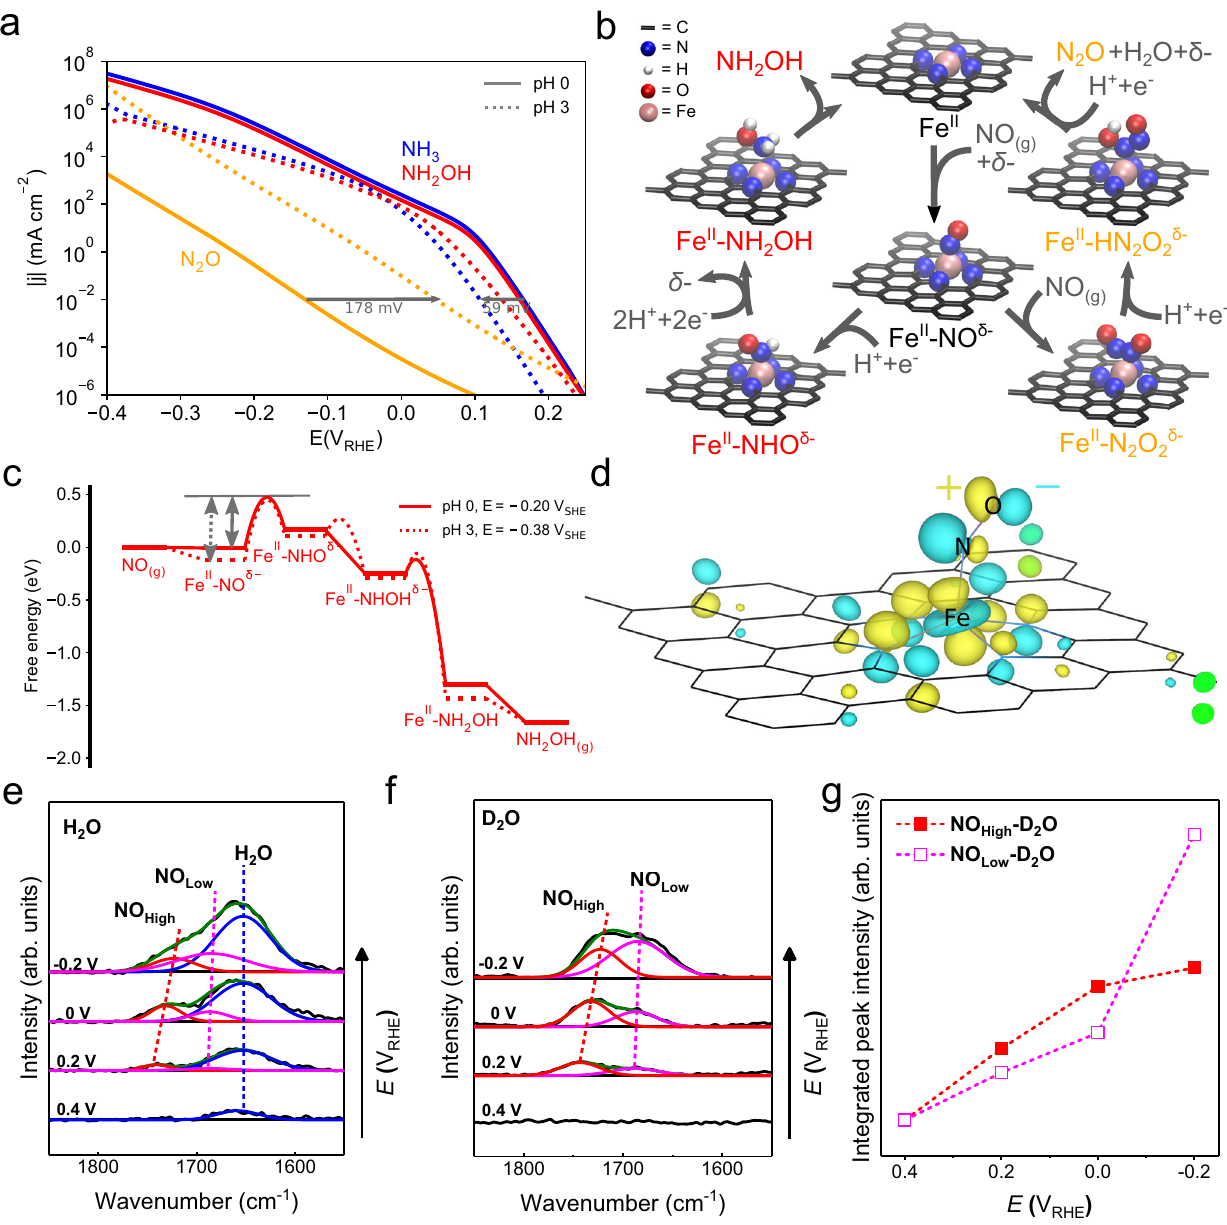
Fig. 3 First-principles based electrochemical multiscale simulation studies and in situ ATR-SEIRAS analyses on the mechanism of NORR at graphene- embedded Fe – N 4 moiety. a Polarisation curves from micro-kinetic modelling relying on HSE06-based adsorption energies showing the partial current densities of three different NORR products for pH 0 and pH 3 on an RHE scale. Horizontal arrows depict the overpotential shift with pH. b Reaction mechanism with the key rate-limiting intermediates as obtained from analysis of the micro-kinetic modelling results. c Free energy diagram for NORR to NH 2 OH (HSE06 level) at − 0.2 V RHE for two different pH values. The grey arrows indicate that the more negative corresponding potential on an SHE scale at pH 3 leads to an additional stabilisation of Fe II – NO δ − relative to the transition state towards the Fe II – NHO δ − state on an RHE scale. The x -axis corresponds to the overall reaction coordinate being decomposed into the elementary steps (containing both PCET and chemical steps). The free energy diagram has been evaluated without accounting for pressures and coverages. d Spin-up HOMO of the Fe II – NO δ − state at the PZC (at the Γ -point and an isovalue of ±1.5 × 10 − 3 ) (RPBE level). In situ ATR-SEIRAS analysis of FeNC-dry-0.5 measured in NO-saturated 1 mM HClO 4 + 0.1 M KClO 4 /H 2 O ( e ) and electrolyte. The IR spectra were collected at constant potentials of 0.4, 0.2, 0, and − 0.2 V RHE with a reference spectrum at 0.8 V RHE